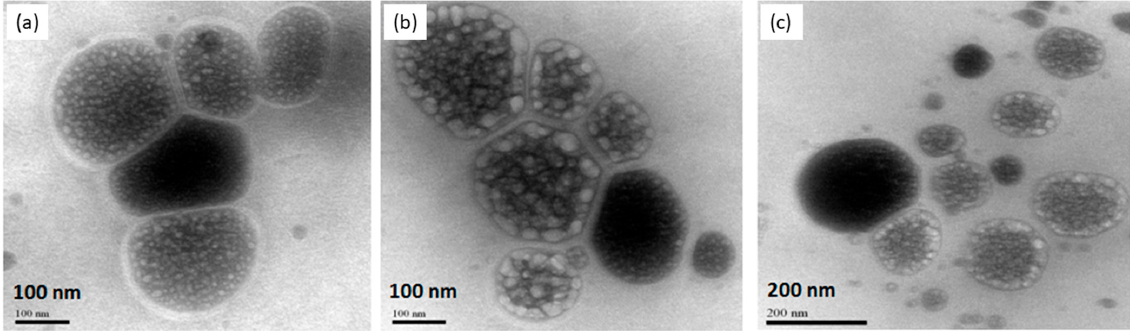
Figure 2. Transmission Electron Microscopy of CP entrapped into liposomes. PC + PL ( a ), PC + LP + CP ( b ), PC + EXT ( c ). Scale bars: 100 nm ( a , b ) and 200 nm ( c ).